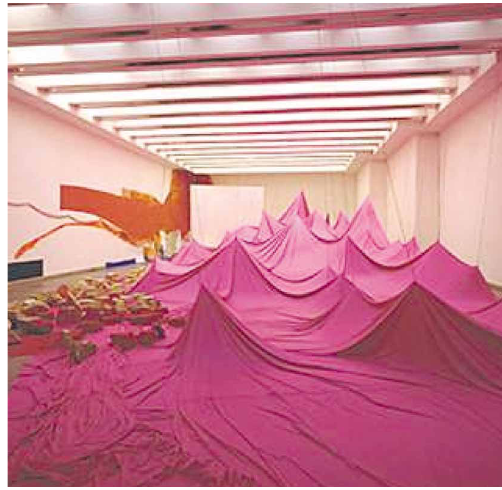
Fig. 2. Jessica Stockholder. Growing Rock Candy Mountain Grasses in Canned Sand , 1992. Installation view, Westfalischer Kunstverein, Münster, Germany. 23×12 m piece of